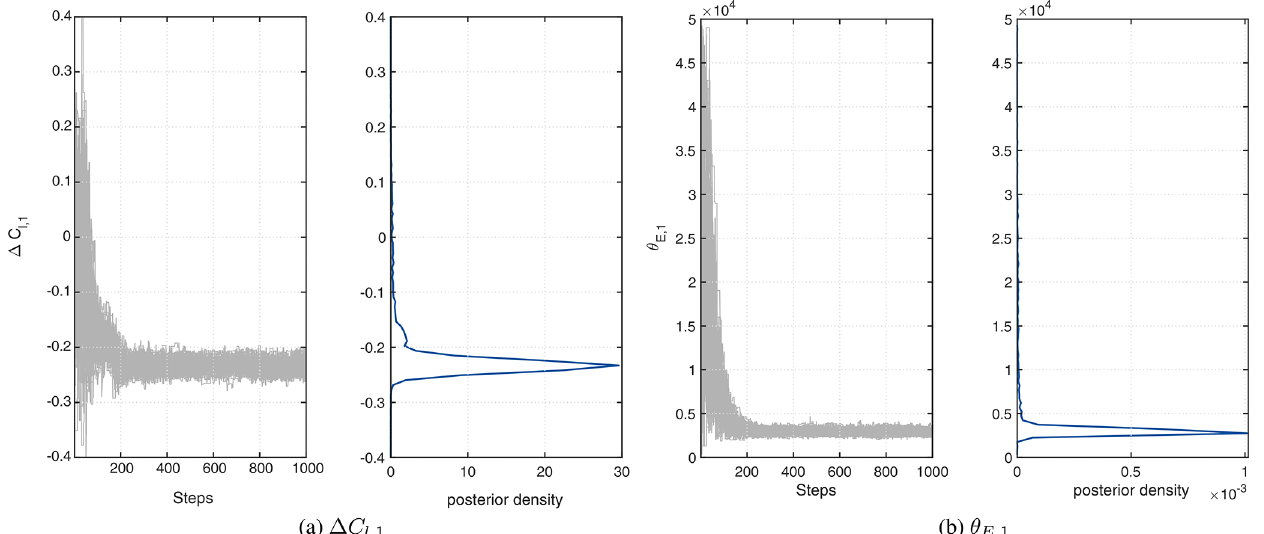
Figure B4. Examples of MCMC chains and resulting posterior for model parameter (cid:49)C l , 1 and hyperparameter θ E, 1 , using 200 measure- ment points. For the results reported in Sect. 5.1, the first 50% of the chains is discarded (so-called